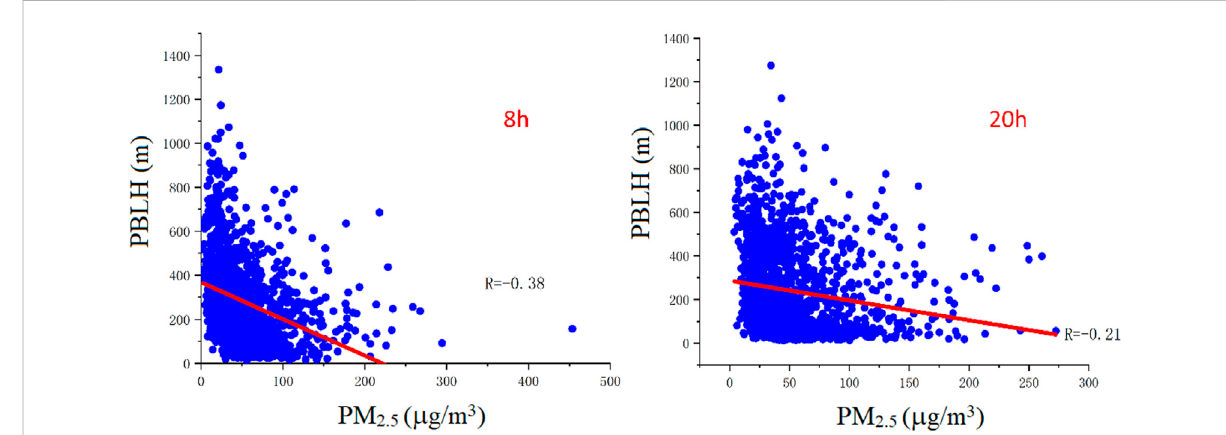
FIGURE 3 Correlation between PBLH and PM 2.5 concentration at 8:00 (BJT) and 20:00 (BJT) in Changsha.